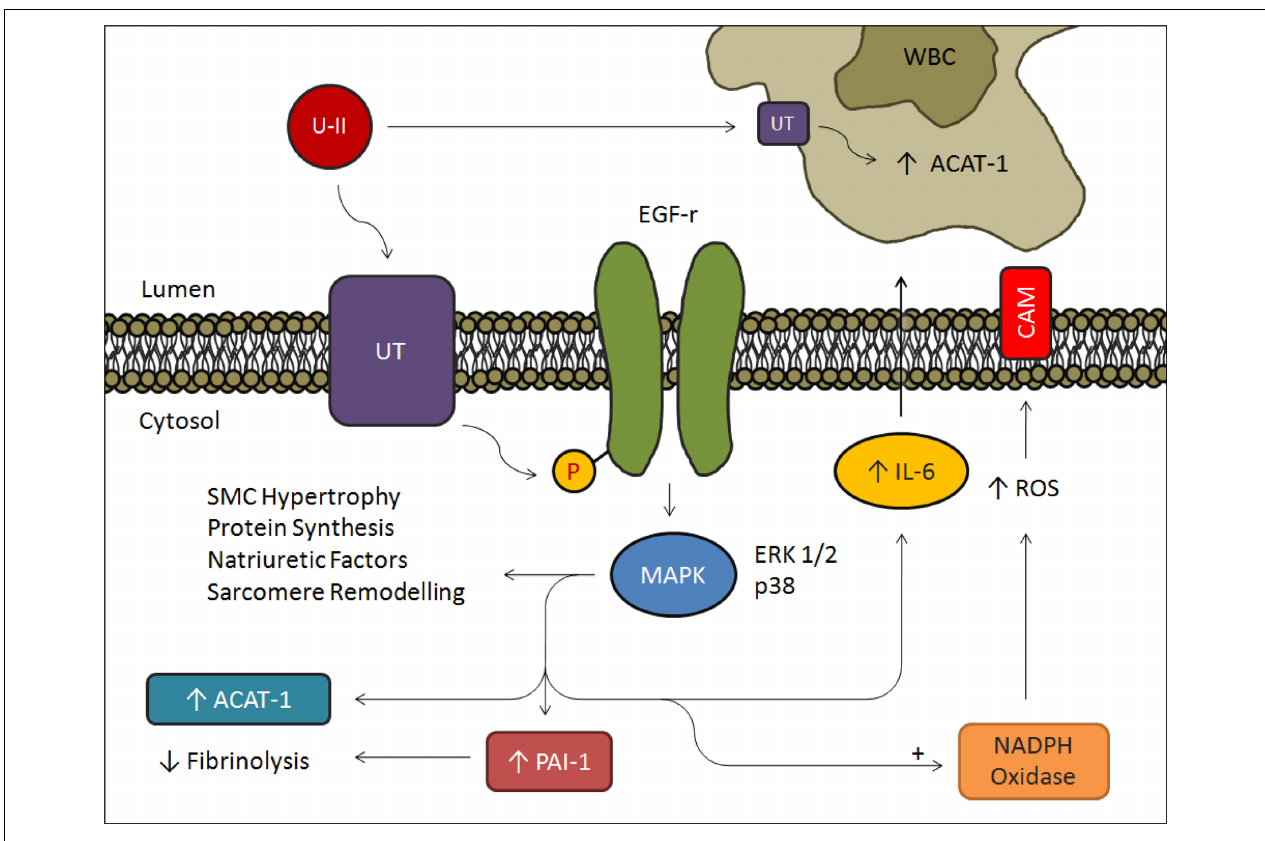
ACAT-1. Furthermore, stimulation of NADPH Oxidase increases cell adhesion molecule expression promoting macrophage infiltration in atherosclerotic vessels. UII binding to macrophage UT increases macrophage ACAT-1 resulting in increased lipid uptake and subsequent foam cell